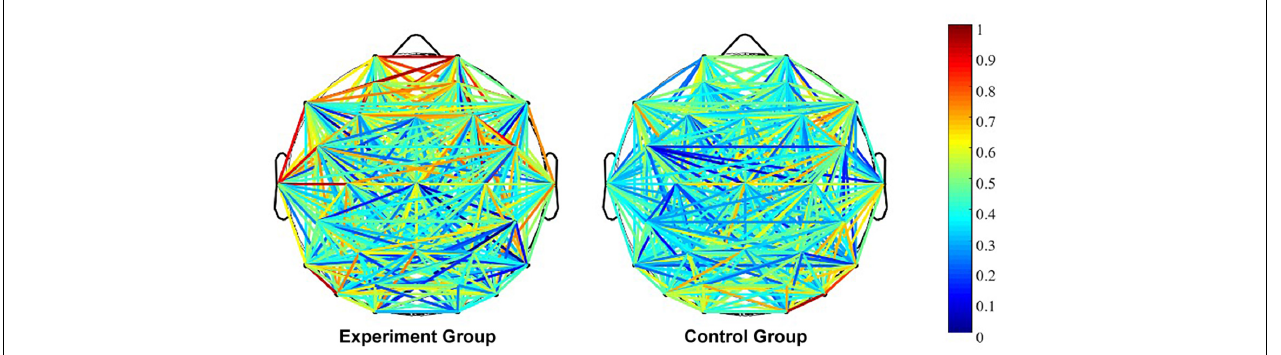
FIGURE 1 | The whole-brain connectivity on beta band. Note: wPLI values presented in line colors.